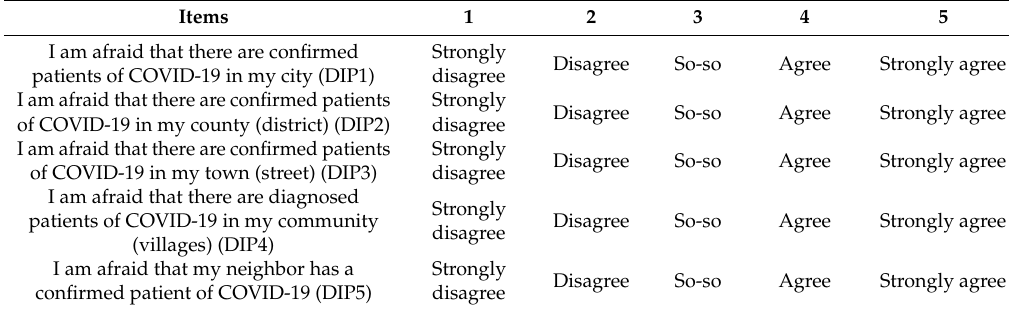
Table A2. Scale to measure distance perception of the COVID-19 crisis.